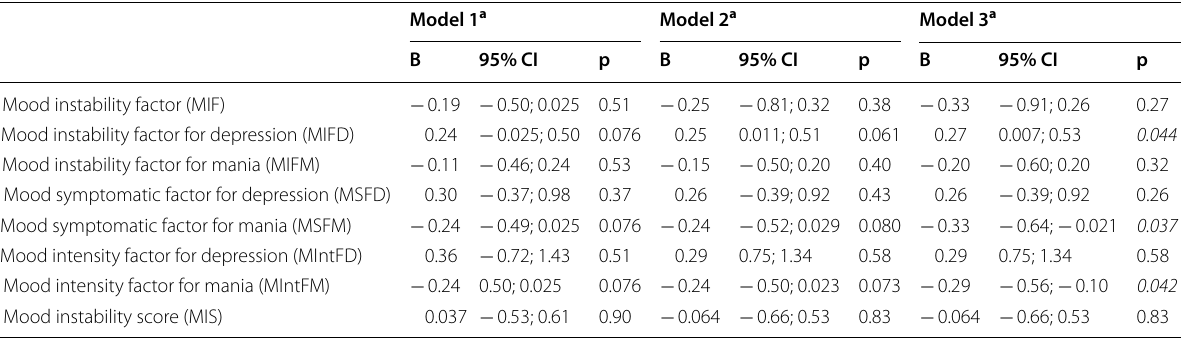
Italic values indicate statistical significance level (p